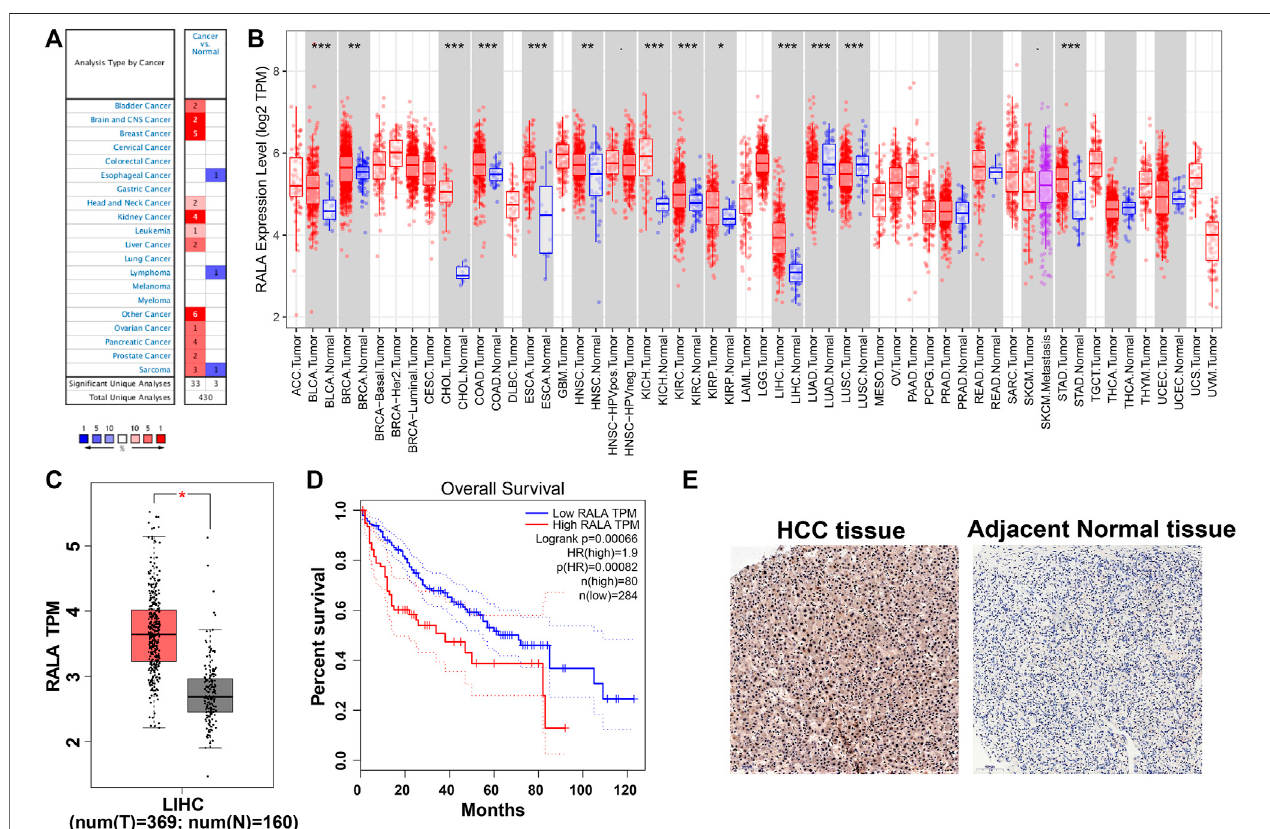
FIGURE2|(A) AnalysisofthedifferentialRalA expression ofvarious cancertypes intheOncomine database; (B) Differentialexpression pro fi les ofvarious cancers and RalA in the TCGA database; (C) Differential expression of RalA protein in HCC and normal tissues; (D) Kalplan – Meier curves of RalA on the overall survival rate of HCC patients in the TCGA database; (E) Protein expression levels of RalA in HCC and adjacent normal tissues detected by IHC, scale bar: 100 μ m.